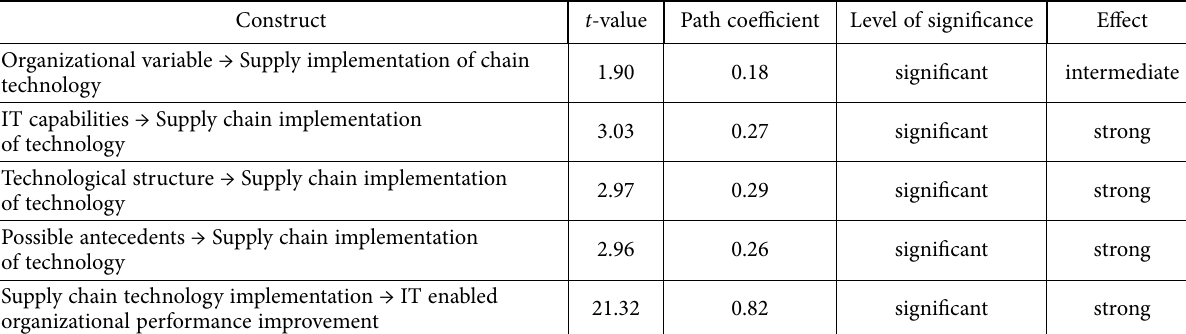
Table 4. The hypothesis tests and results’